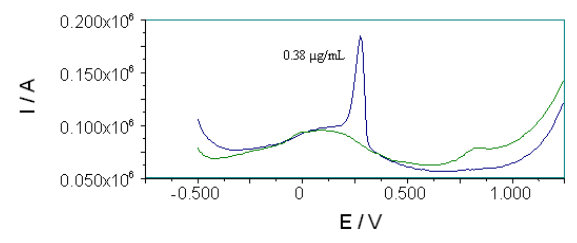
Figure 6 : Differential pulse anodic stripping voltammograms obtained for determination of Ag + in reaction mixture sample on glassy carbon electrode.